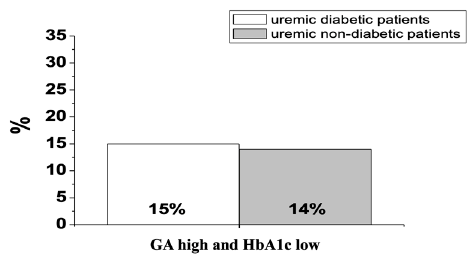
Figure 4. Percentage of discordant values between GA and HbA1c in Group 1 (uremic diabetic patients) and Group 2 (uremic non-diabetic patients). Abbreviations: GA, glycated albumin; HbA1c, glycated